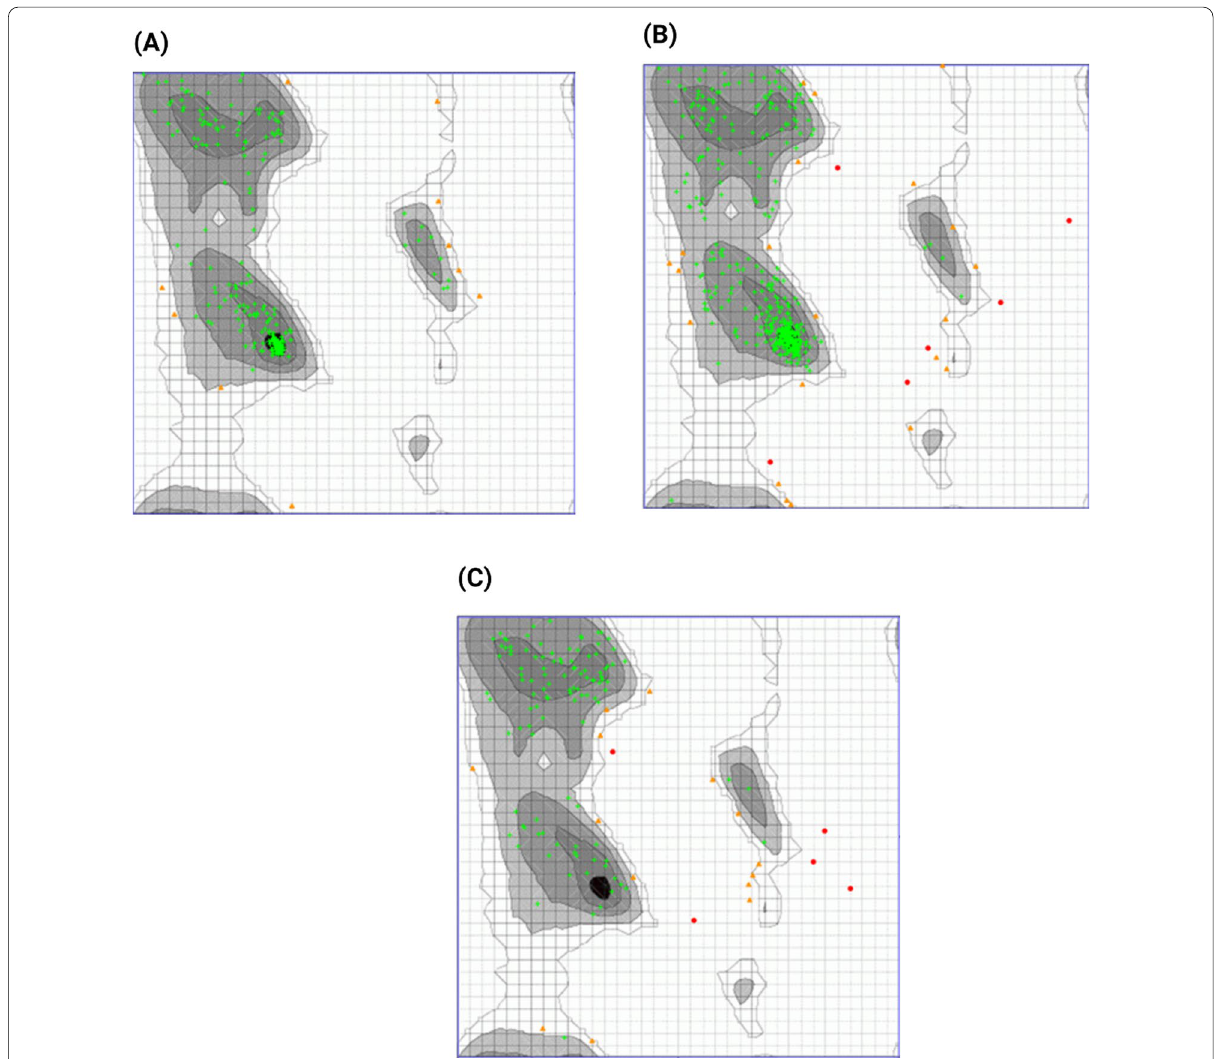
Fig. 3 Ramachandran plot of CotH3 protein structure showing the percentage of residues in the highly Preferred observations shown as GREEN Crosses: 217 (95.595%), preferred observations shown as BROWN Triangles: 10 (4.405%) and questionable observations shown as RED Circles: 0 (0.000%) ( a ). Ramachandran plot of Lanosterol 14 alpha-demethylase protein structure showing the percentage of residues in the highly preferred observations shown as GREEN Crosses: 418 (93.933%), preferred observations shown as BROWN triangles: 21 (4.719%) and questionable observations shown as RED circles: 6 (1.348%) ( b ). Ramachandran plot of Mucoricin protein structure showing the percentage of residues in the highly preferred observations shown as GREEN crosses: 113 (85.606%), preferred observations shown as BROWN triangles: 14 (10.606%) and questionable observations shown as RED Circles: 5 (3.788%) ( c